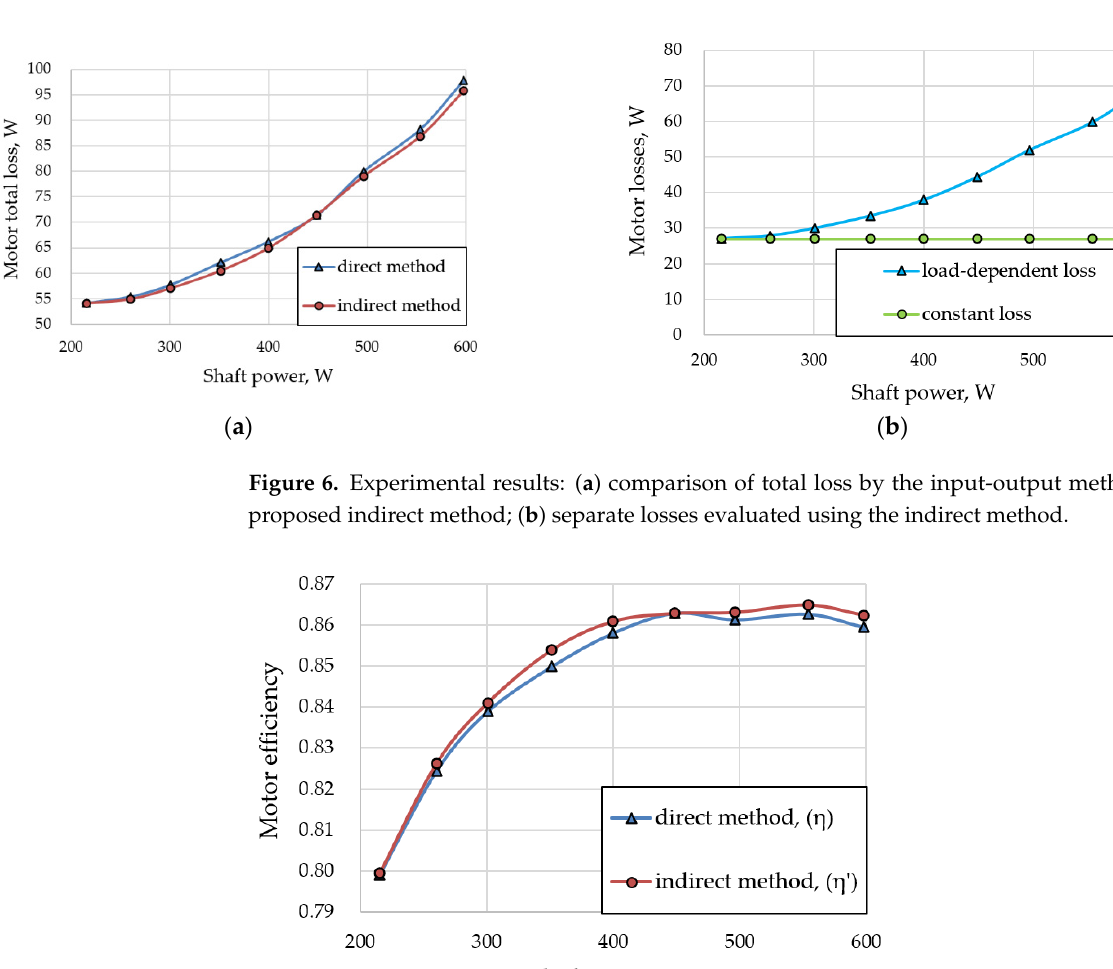
Figure 7. Comparison of motor efficiency measured by the input-output method and the proposed indirect method.